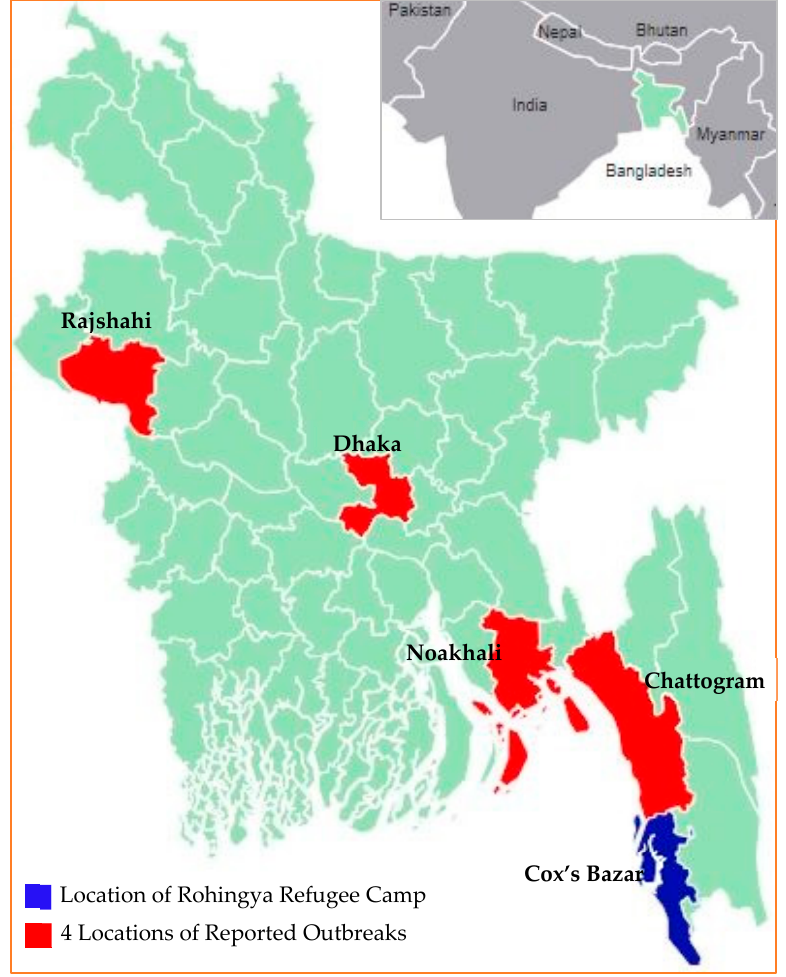
Figure 1 . Map showing reported outbreak and refugee camp locations in Bangladesh . Figure 1. Map showing reported outbreak and refugee camp locations in